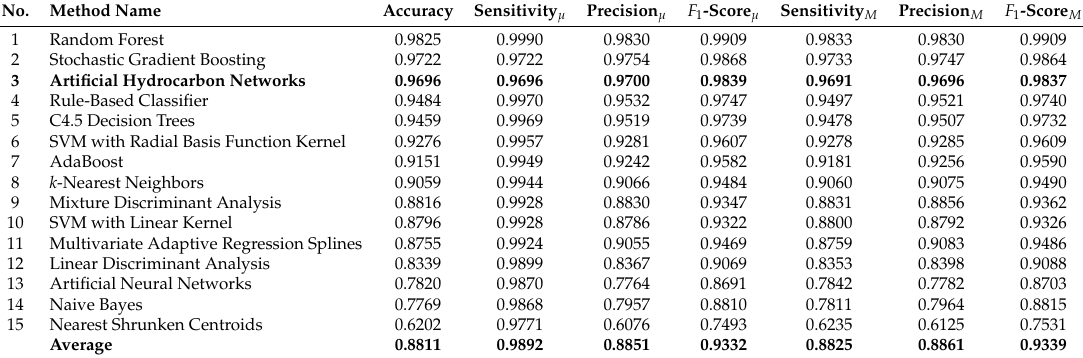
Table 8. Comparison of the supervised classifiers using the 7% noisy dataset of the case